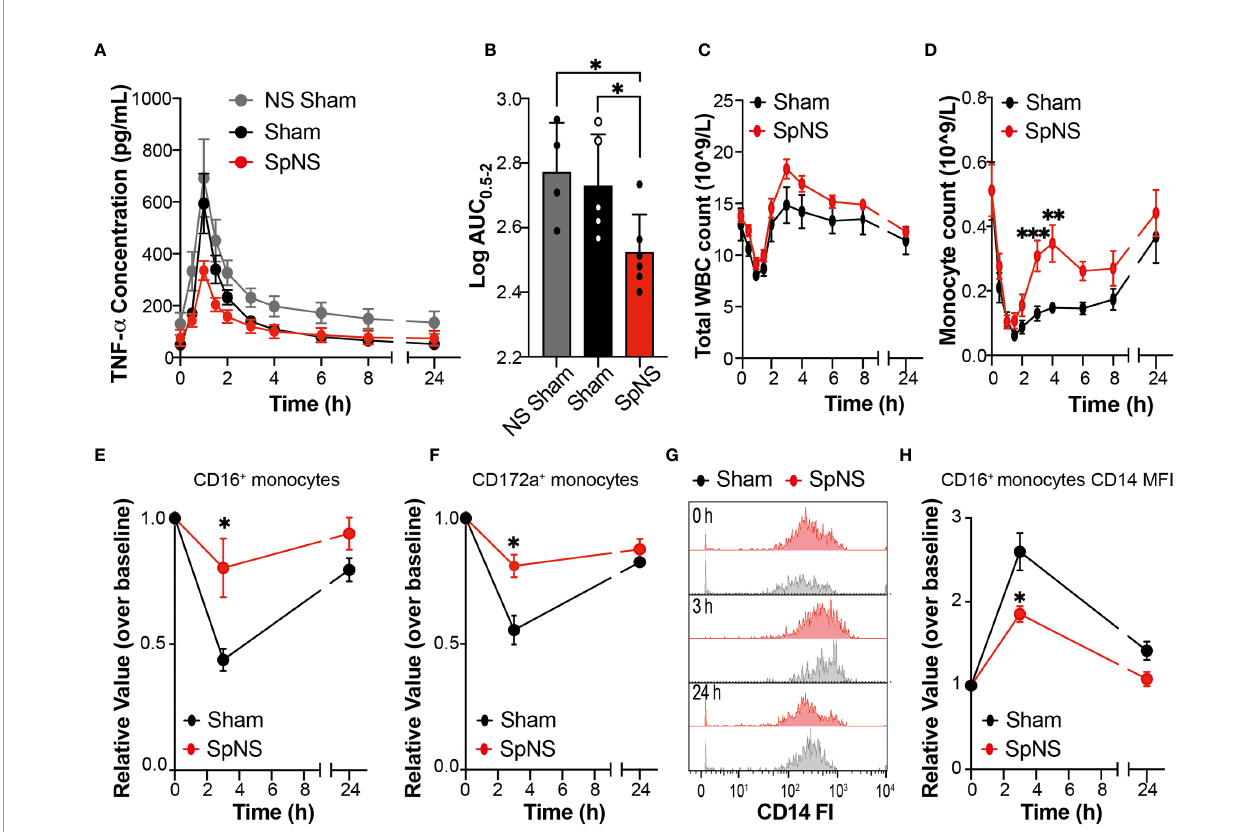
FIGURE 4 | Chronic SpN Neuromodulation Evokes Anti-In fl ammatory Effects During LPS-Induced Endotoxemia. (A) Graphs showing TNF- a concentration quanti fi ed in the peripheral plasma collected at different time points after i.v. injection of 0.025 µg/kg of LPS. The data are shown for non-surgical (NS) sham (grey), sham (black) and SpNS (red) animals. (B) Graph showing the quanti fi cation of the relevant TNF- a AUC (between 0.5-2 h post LPS) derived from (A) . Data are shown and were analyzed using the expressed as Log 10 normalized AUC values. The single data points with mean are shown (C, D) Graphs showing total white blood cell (C) or monocyte (D) cell counts from peripheral blood between 0 and 24 h post LPS injection. (E, F) Quanti fi cation of peripheral blood monocytes stained with antibodies against CD16 (E) or CD172a (F) over time. (G) Representative histograms showing the changes over time of CD14 expression on CD16 + monocytes in a sham and a SpNS representative pig. (H) Quanti fi cation of the median fl uorescence intensity (MFI) of CD14 expression on CD16 + monocytes over time. (A, C – F, H) Data are expressed as mean ± s.e.m. (E, F, H) Data are expressed as relative change over the baseline (value prior to LPS injection). (A, B) n = 6 for SpNS; n = 5 for sham. (C – E) n = 6 for SpNS; n = 5 for sham. (E, F, H) n = 3 for SpNS; n = 4 for sham. The sham group is shown in black and SpNS group in red. *P ≤ 0.05; **P ≤ 0.01; ***P ≤ 0.001 vs Sham or NS